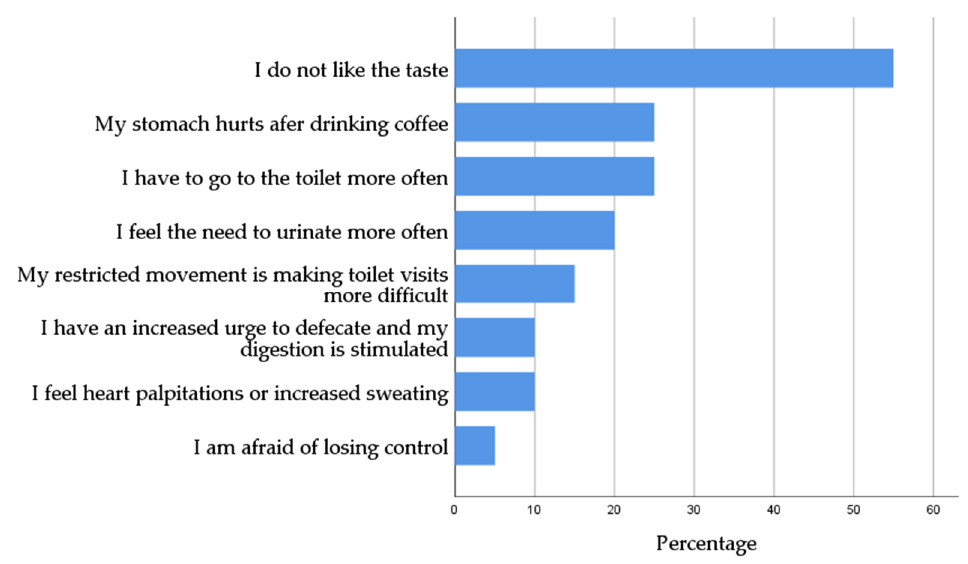
Figure 2. Distribution of sleep quality data in the groups “regular coffee” (RC) and “no coffee” (NC). In the group with RC consumption, patients with an average daily coffee intake of more than 0.5 cups ( n = 104) are shown. In the group of NC, patients with an average daily coffee intake of lower than 0.5 cups ( n = 20) are shown. There was no difference in sleep quality regarding coffee consumption ( p , statistical significance).